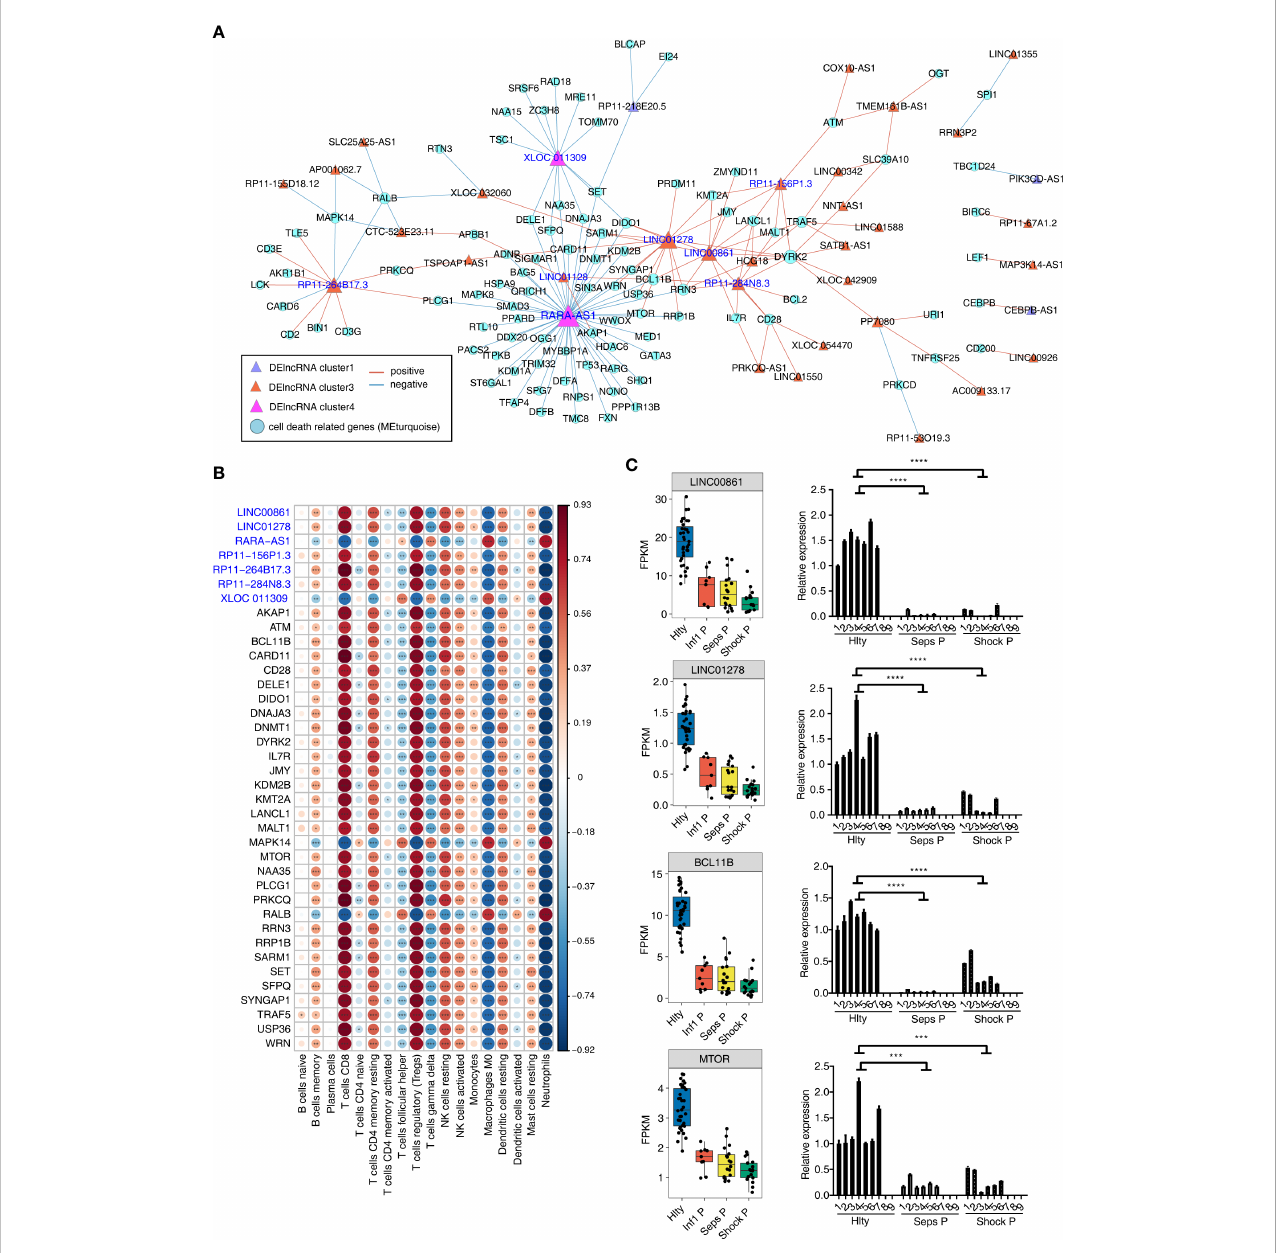
FIGURE 4 Construction of co-disturbed network between immune microenvironment associated lncRNAs and cell death genes. (A) The co-disturbed network between expression of immune cell related DElncRNAs and expression of cell death-related genes from three related WGCNA modules was constructed using 79 samples. |Pearson ’ s correlation| ≤ -0.85 or ≥ 0.95 and P-value ≤ 0.01 were retained. Circles indicate cell death-related genes and triangles indicate DE lncRNA. Lines between nodes indicate correlation between DElncRNAs and cell death-related genes. Node size indicates connections. (B) The dot-plot demonstrated the correlations between sample traits (each cell type) and expression of each dysregulated DElncRNAs and their target cell death related genes. Different colors indicate positive (red) or negative (blue) correlation and signi fi cant ones were labeled with star. *P ≤ 0.05; **P ≤ 0.01; ***P ≤ 0.001. (C) Boxplot and barplot showing expression pro fi le of lncRNA-mRNA pairs (LINC00861-BCL11B; LINC01278-MTOR) in different groups. The left boxplots showing the expression by RNA-seq, the right showing the clinical validation by qRT-PCR. ***P ≤ 0.001, ****P ≤